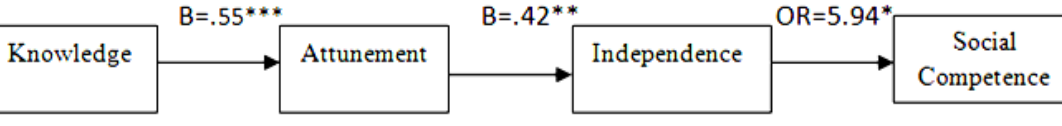
= 0.28), p ≤ 0.001. adj = 0.15), adj